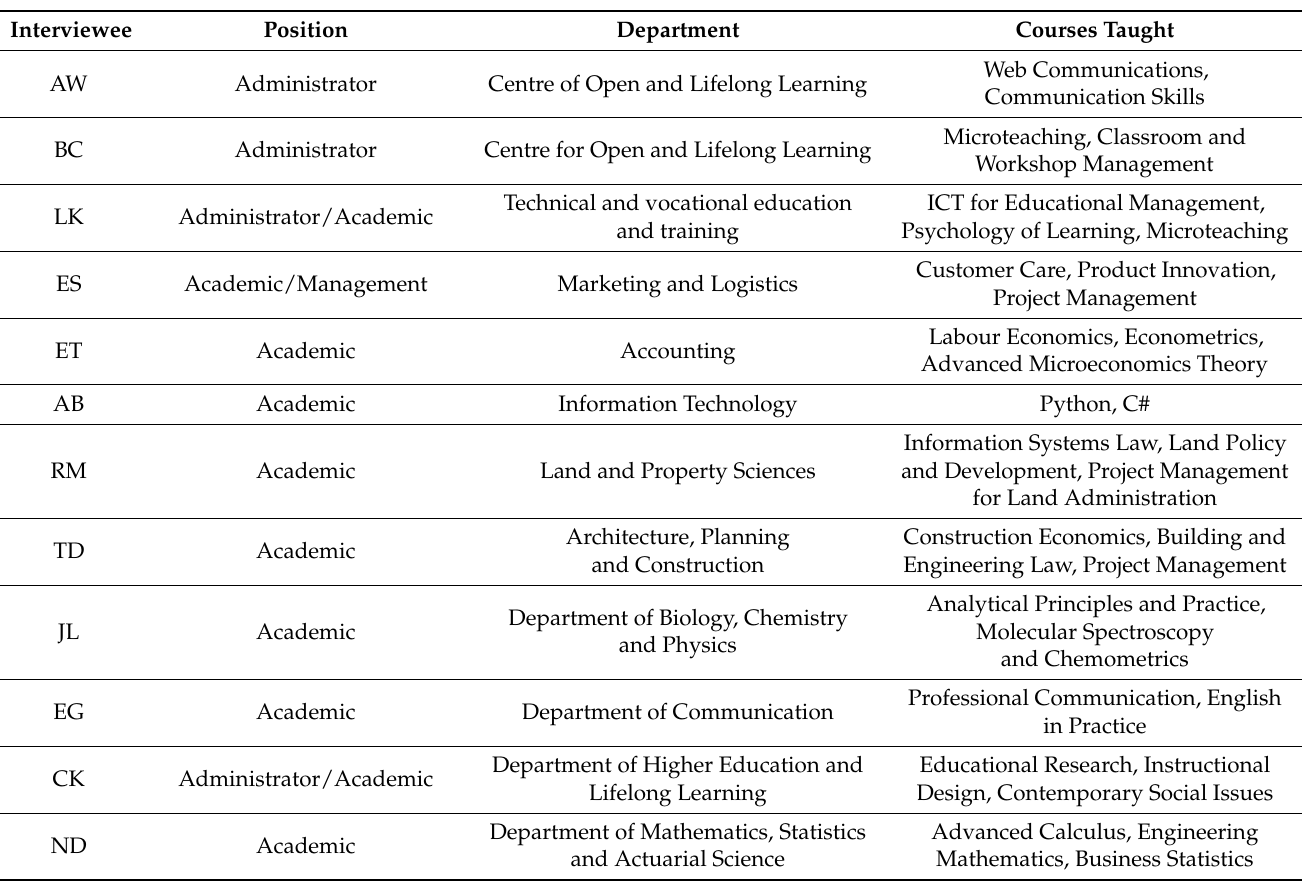
Table 1. Demographic profile of